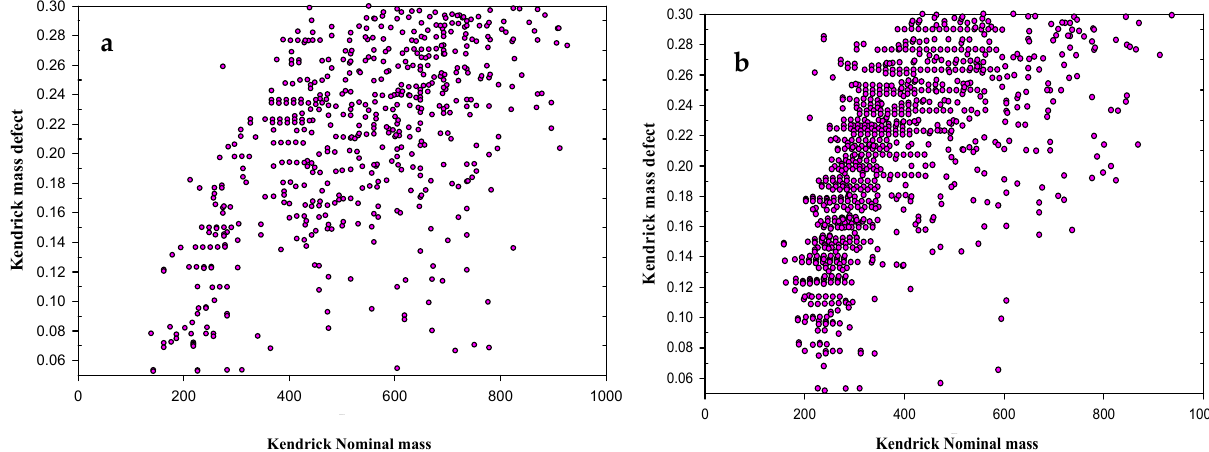
Figure 10. Kendrick mass plot of the O 1 –O 10 species found in the not-treated WSF of crude oil ( a ) and after 1-h of US treatment ( b ).